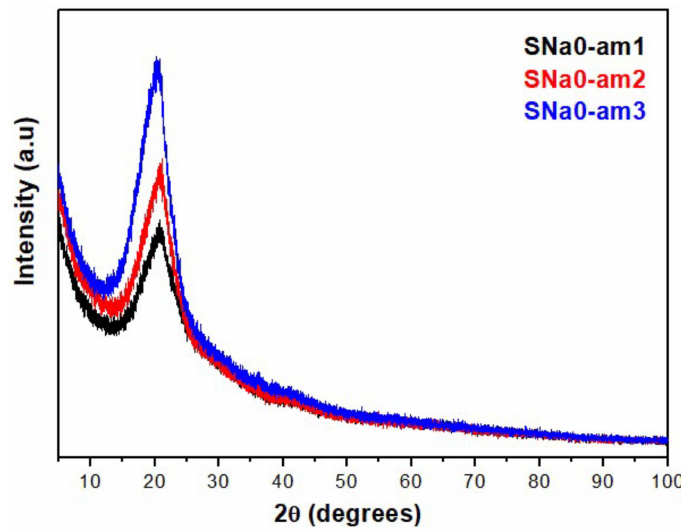
Figure 8. Patterns of diffraction via XRD of three different regions from the same sample of pure polymer film (SNa0).